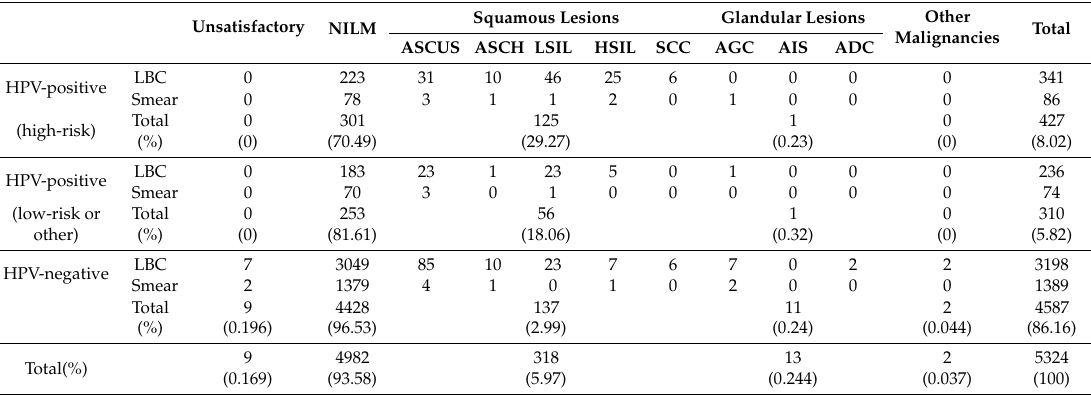
Table 8. HPV infection and cytologic diagnosis in the MyHPV CHIP ™ group.